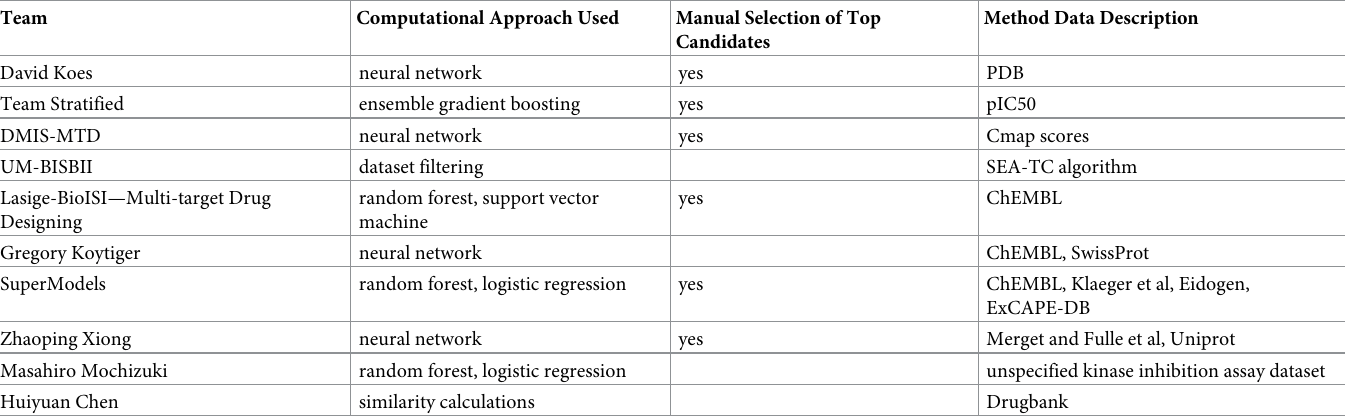
Table 3. Methods summary table. “Computational Approach Used” describes the methods that were mentioned in each team’s writeup (see S1 Methods). “Manual Selec- tion of Top Candidates” indicates whether a team described using a manual curation step to produce their final set of predicted compounds. “Method Data Description” highlights the data sources and data types used by each